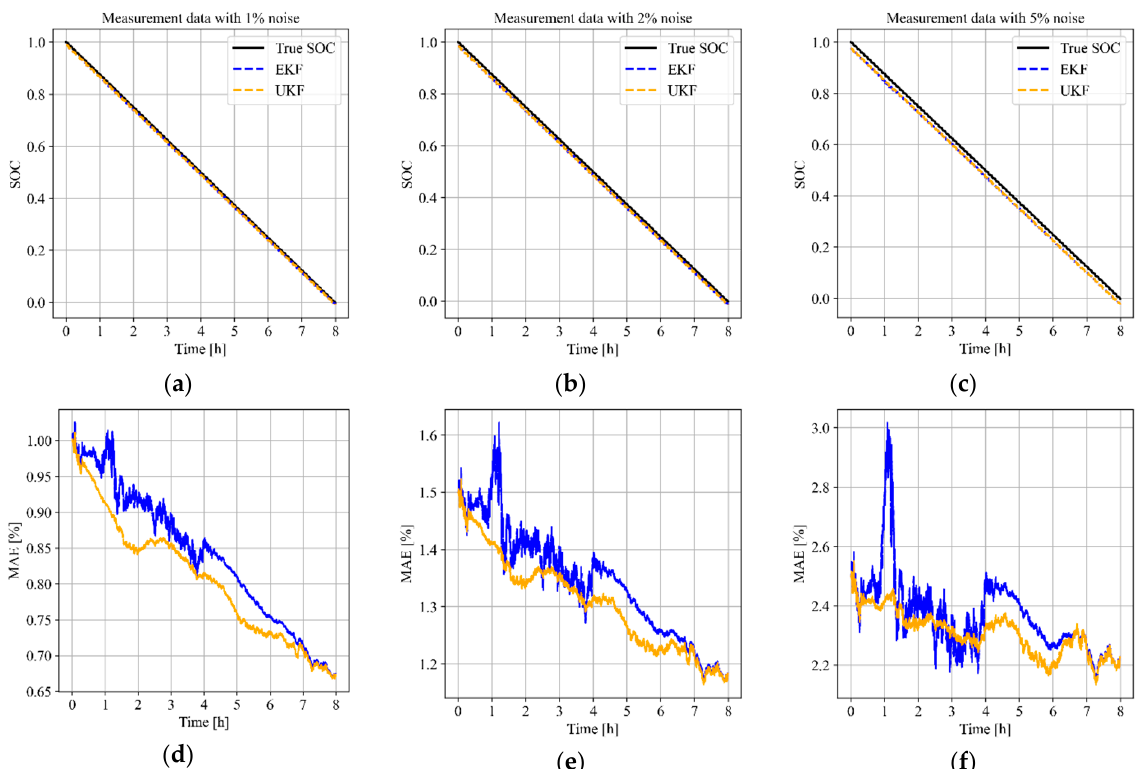
Figure 11. Estimation results in operating temperature 25 °C: true SOC vs. estimation methods according to including noise ( a ) 1%, ( b ) 2%, ( c ) 5%. Difference between the true SOC and the estimated SOC of the estimation methods in noise ( d ) 1%, ( e ) 2%, ( f ) 5%.